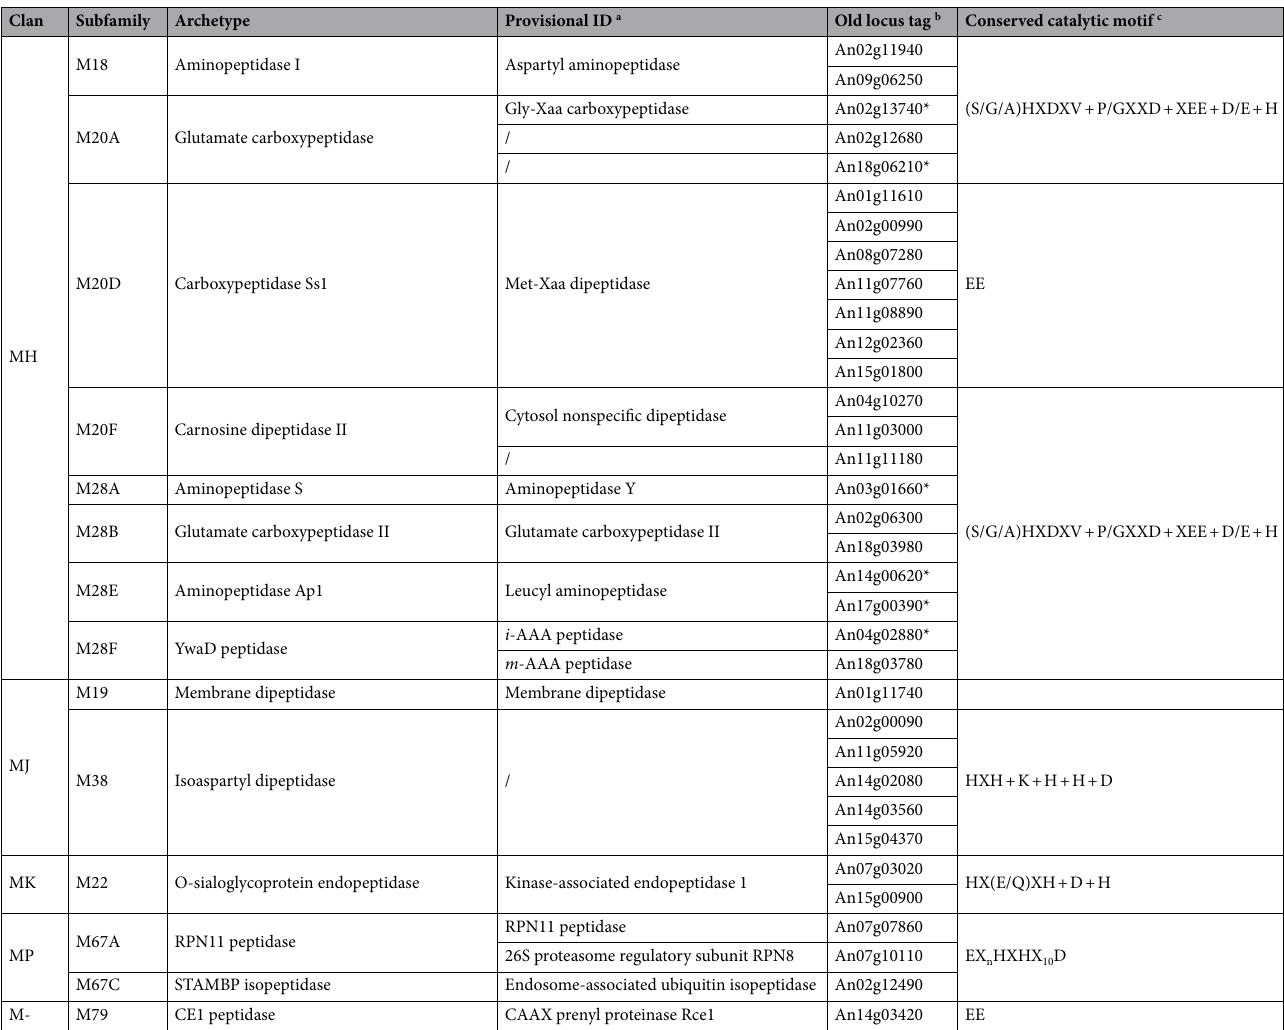
Table 7. Metallopeptidases encoded by A. niger strains CBS 513.88 and ATCC 1015. a /, not provisionally identified; b Proteases that have been molecularly and/or biochemically characterized are in bold; c Putative catalytic residues, metal-binding residues and residues occupying the position of the Met-turn or Ser/Gly- turn beneath the metal sites are colored in pink, green and orange, respectively. Other residues involved in stabilization of the reaction intermediate, substrate binding, and/or catalysis are shown in black, except for X, which denotes any amino acid and is only used as a spacer within motifs; * Secreted proteases that have been predicted by the six predictors, the unassigned extracellular metallopeptidase An06g00780 is not listed in this